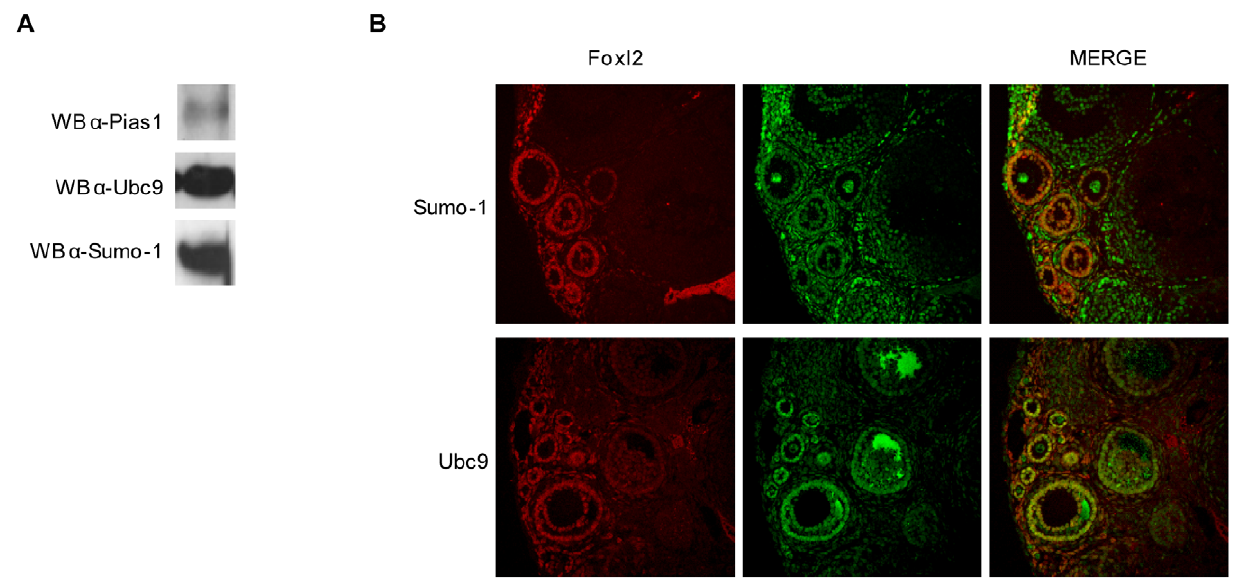
Figure 3. Foxl2, Sumo-1 and Ubc9 are expressed in mouse ovary. A. Pias1, Ubc9 and Sumo-1 are expressed in 4 week mouse ovaries: 4-week old mouse ovaries were lysed and analysed by immunoblotting with anti- Pias1, Ubc9, and Sumo-1 specific antibodies. 50 ug of protein were loaded in each lane. B. Co-Localization of Foxl2, Sumo-1 and Ubc9 in 4 week-old mouse ovary: Hybridization with anti-Foxl2 (red) and anti-Ubc9 (green) or anti-Sumo-1 (green) antibodies. Yellow spots in the 40 6 magnification show the co-localization of Foxl2 with Ubc9 and Sumo-1, especially in primordial and primary follicle granulosa cells. Immunofluorescence analysis was performed using a Leica DMIRE2-TCS-SL Confocal Laser Scanning microscope (from 488 to 633 excitation wavelength).